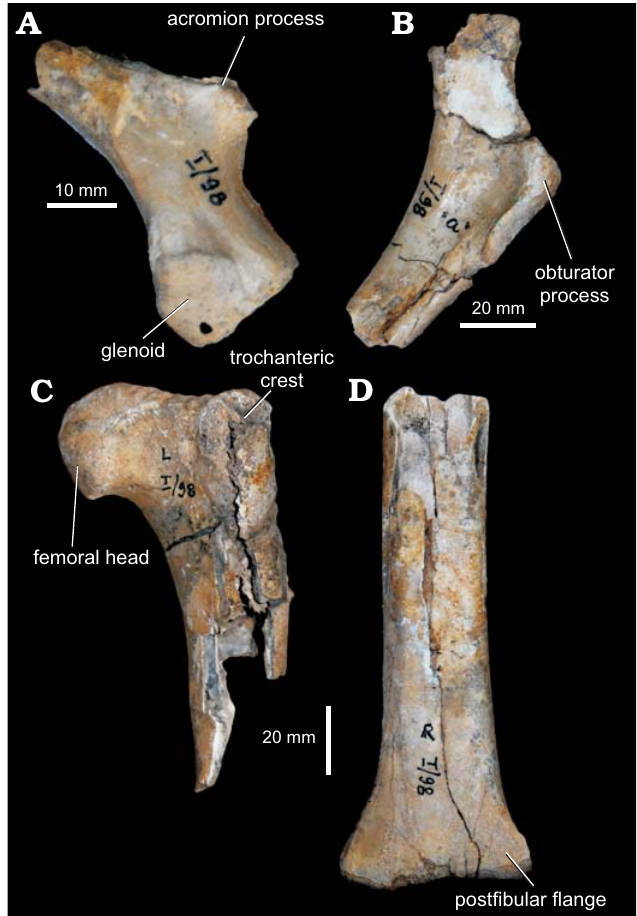
Fig. 4. Crested theropod dinosaur Elmisaurus rarus Osmólska, 1981, ZPAL MgD-I/98 from Nemegt Formation (Upper Cretaceous), Western Sayr of Nemegt locality, Mongolia. Proximal portion of right scapula in lateral view ( A ); proximal portion of right ischium in lateral view ( B ); proximal head of left femur in anterior view ( C ); distal end of right tibia in posterior view ( D